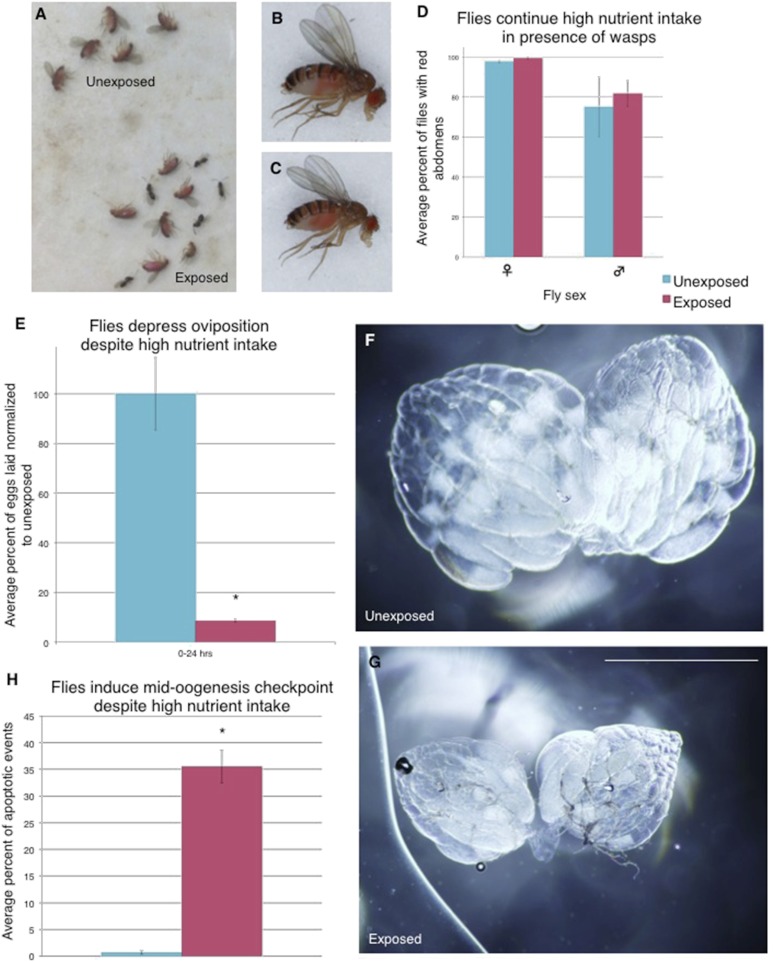
Flies continue to eat high-protein diet following wasp exposure but still depress oviposition.Continued oviposition depression cannot be explained by a lack of nutrient intake that normally inactivates insulin signaling. The high-nutrient intake by exposed female flies suggests that an active insulin signaling pathway is inhibited or bypassed downstream of nutrient sensing. (A) Exposed and unexposed flies anesthetized immediately after 24-hr exposure period shows red food in abdomens. (B) Lateral view of unexposed fly. (C) Lateral view of exposed fly. (D) Percent of male and female flies with red food in abdomen, error bars are 95% confidence intervals. (E) Percent of eggs laid normalized to unexposed following 24-hr exposure period. All eggs on the food plate were counted, including eggs on the yeast paste. (F) Representative ovary dissected from unexposed fly. 36 total ovaries were dissected and examined across 3 replicates for each treatment. (G) Ovary dissected from exposed fly. Scale bar for (F) to (G) is 1.0 mm. (H) Average percent apoptosis in mid-oogenesis checkpoint for unexposed and exposed Canton S. For (D), (E), and (H), error bars represent standard error (n = 3 biological replicates. For (D), 100 female and 20 male flies were counted per replicate. For (E), 3 egg lay plates were counted per treatment. For (H), 3 biological replicates from which 12 ovaries were scored for each group) (*p < 0.05).